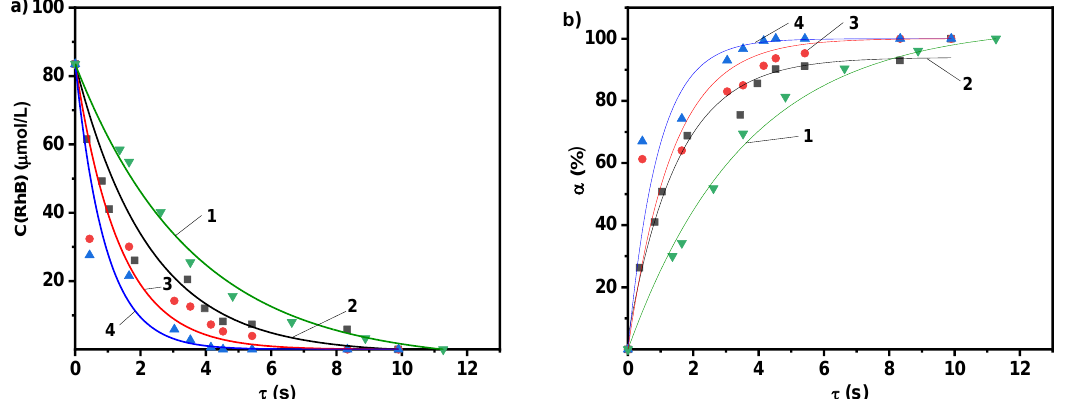
Figure 5. Kinetics ( a ) and efficiency ( b ) of RhB destruction (initial concentration of 40 mg/L): dielectric barrier discharge (DBD) plasmolysis (1); DBD plasmolysis in the presence of catalysts: TiO 2 -PMM (2), TiO 2 -PMMH (3) and TiO 2 -PAMMH (4). Processing conditions: carrier gas flow rate is 0.5 L/min, the discharge current is 3.2 mA, and discharge current frequency is 500 Hz; discharge power is 20 W/cm 3.